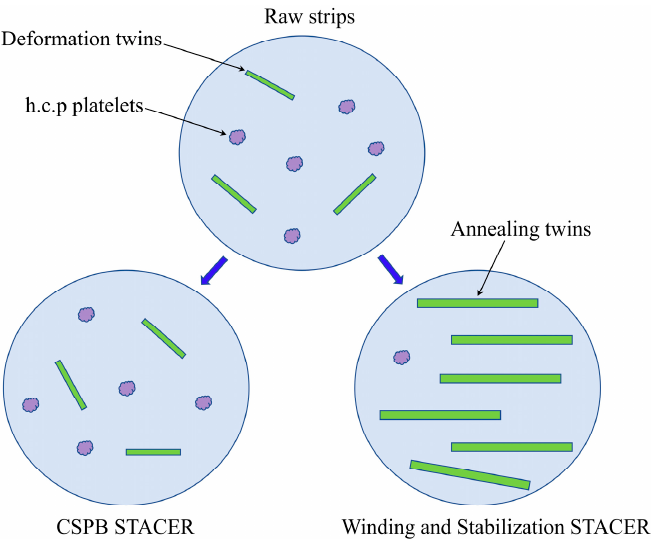
Figure 13. Schematic plot of strengthening mechanisms for raw strips, CSPB STACER, and winding and stabilization STACER.